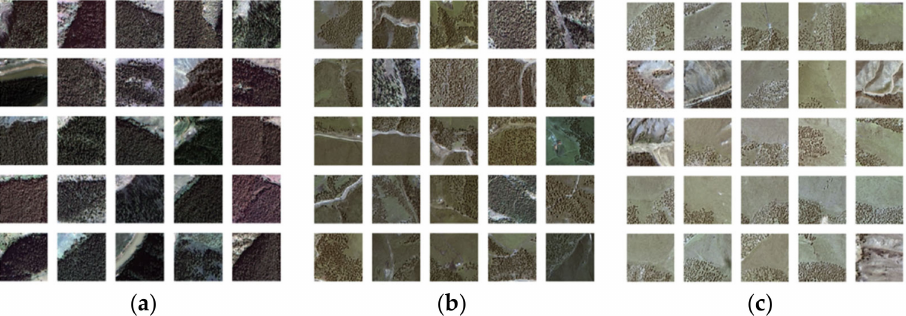
Figure 5. Categories visualization for forest samples from Figure 4: ( a ) category 1, ( b ) category 2 ( c ) category